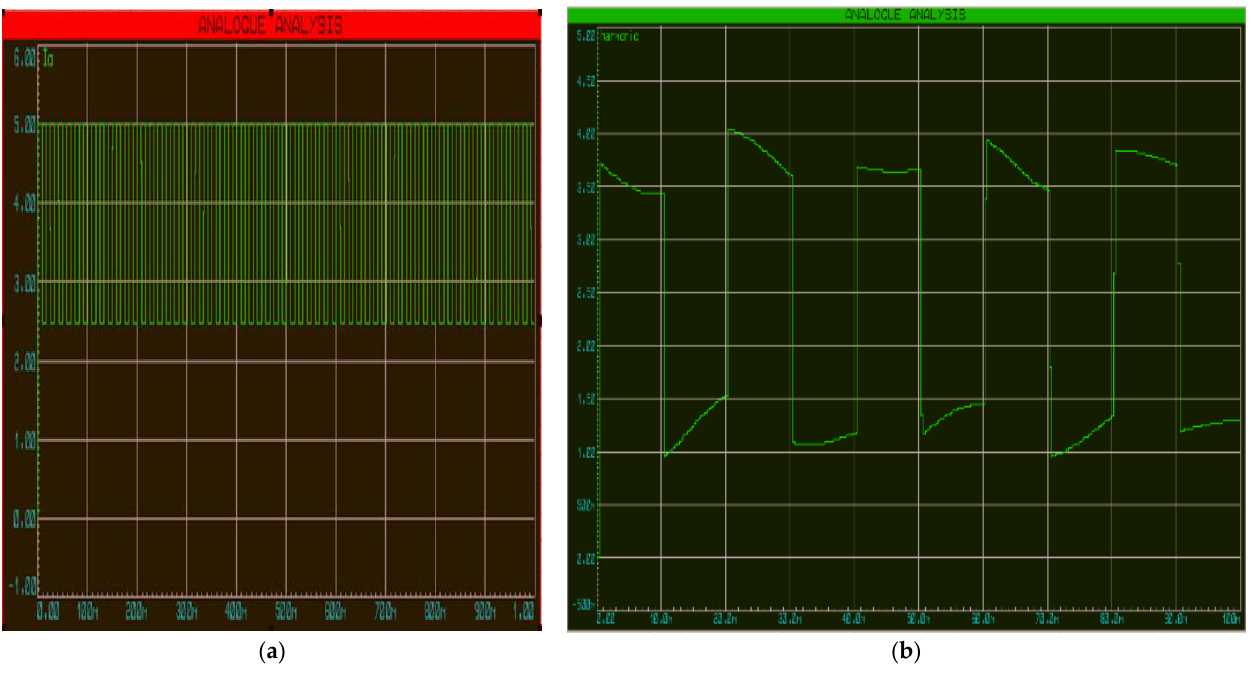
Figure 15. Simulation results of digital notch filter signals using Proteus VMS. ( a ) Nonlinear current waveform; ( b ) harmonic current waveform.